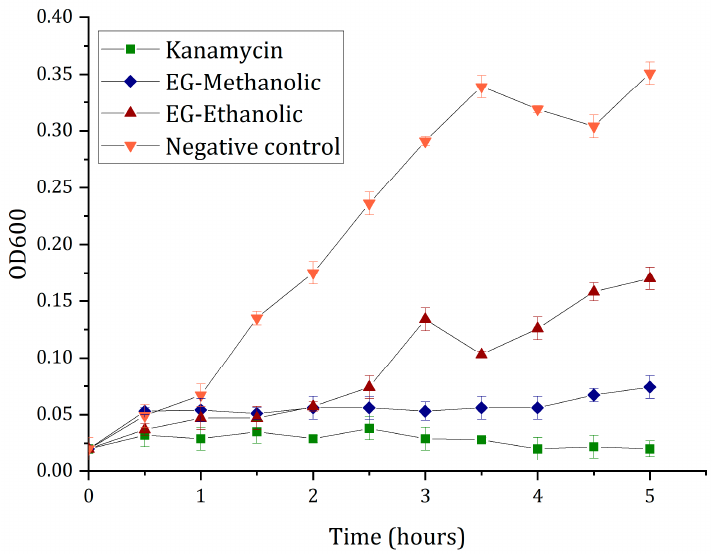
Figure 5. Time–kill curves analysis of the plant extract against E. coli DH5- α growth. Figure 5. Time-kill curves analysis of the plant extract against E. coli DH5- α